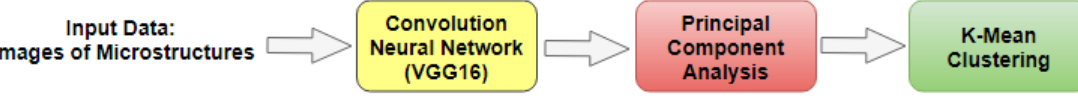
Figure 4. Framework of methodology for clustering the images using k -Means clustering method.